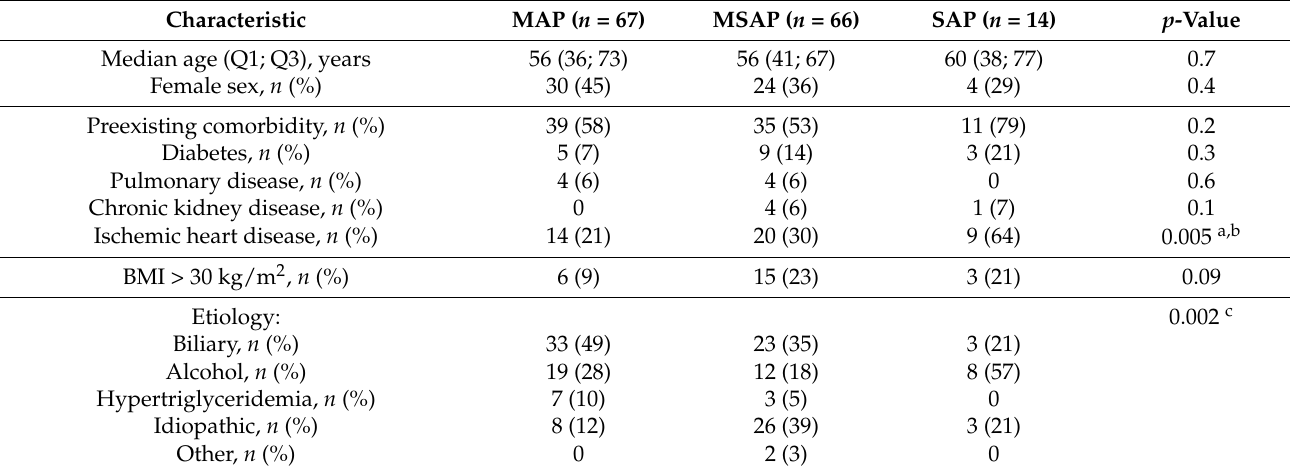
Table 1. Clinical characteristics of patients with AP included in the